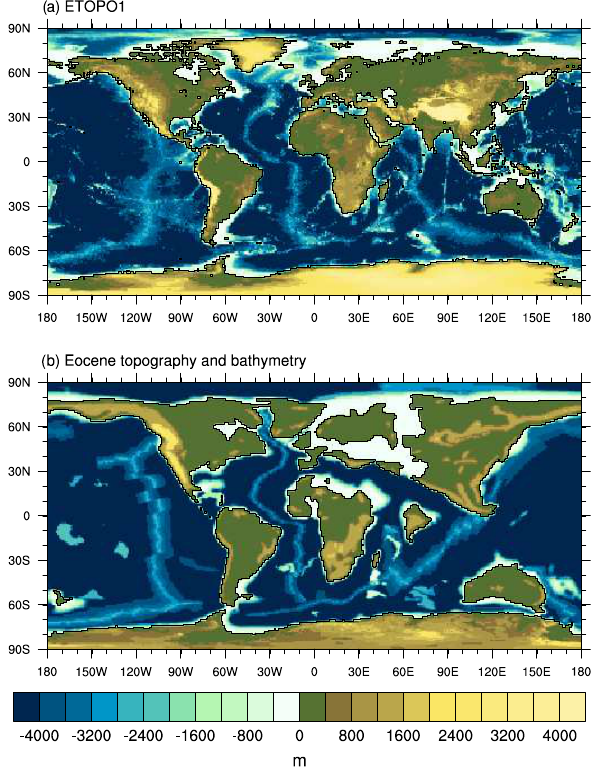
Figure 4. (a) ETOPO1 topography and bathymetry, (b) new Eocene topography and bathymetry. Both at 1 ◦ × 1 ◦